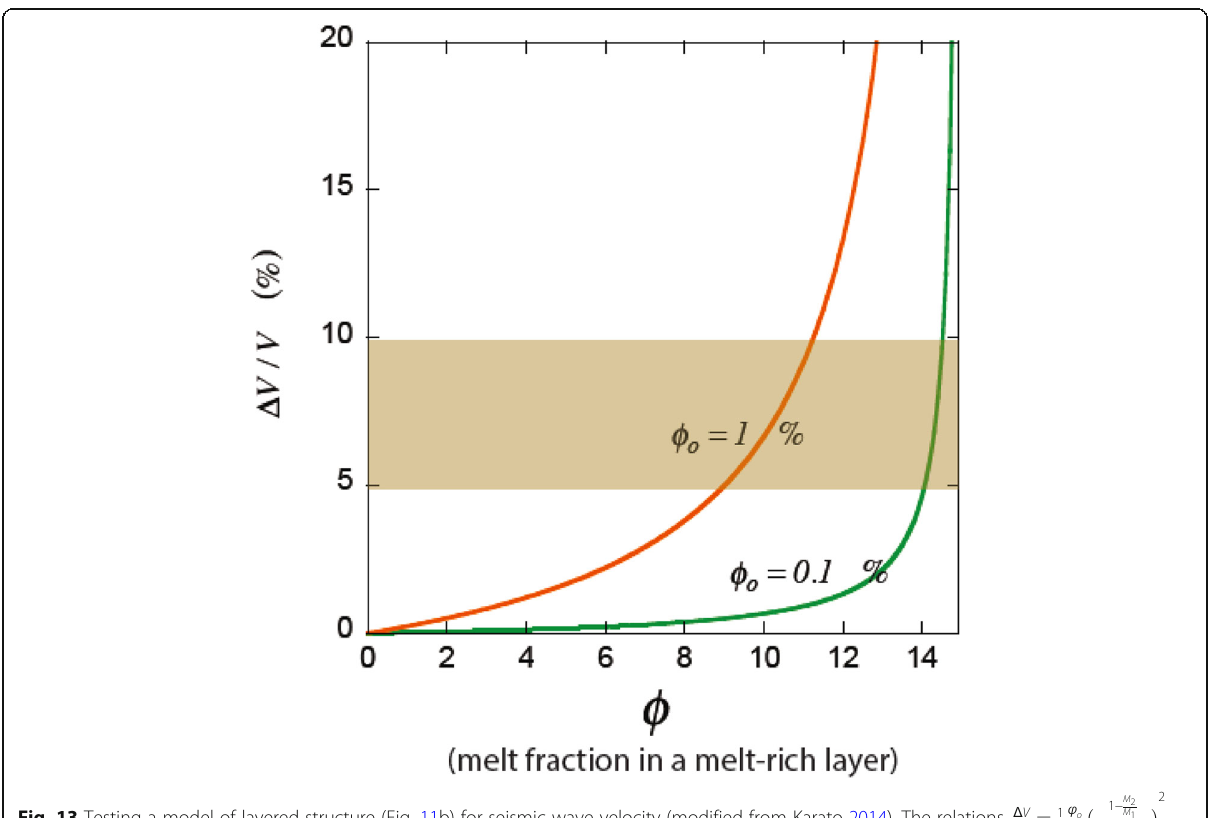
Fig. 13 Testing a model of layered structure (Fig. 11b) for seismic wave velocity (modified from Karato 2014). The relations, Δ V ¼ 1 − A (cid:3) ϕ ( A = 0.067, Takei 2002) are used. The melt fraction of the melt-rich layers needs to be in a very narrow range (Karato 2008) and M 2 M 1 (14 ± 1%) in order to explain the observed 5 – 10% velocity drop at the lithosphere-asthenosphere boundary for the net melt fraction of ϕ o = 0.001 – 0.003 (Hirschmann